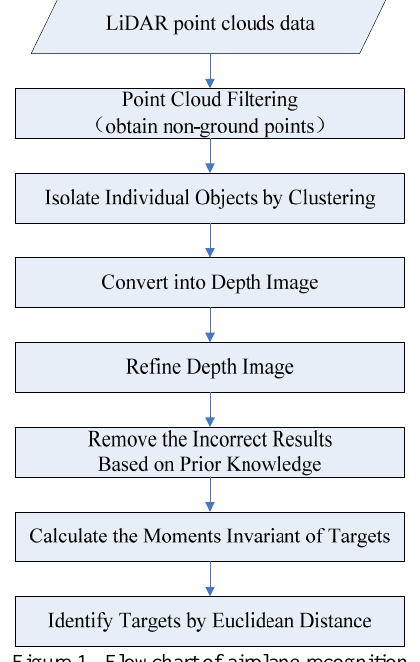
Figure 1. Flowchart of airplane recognition